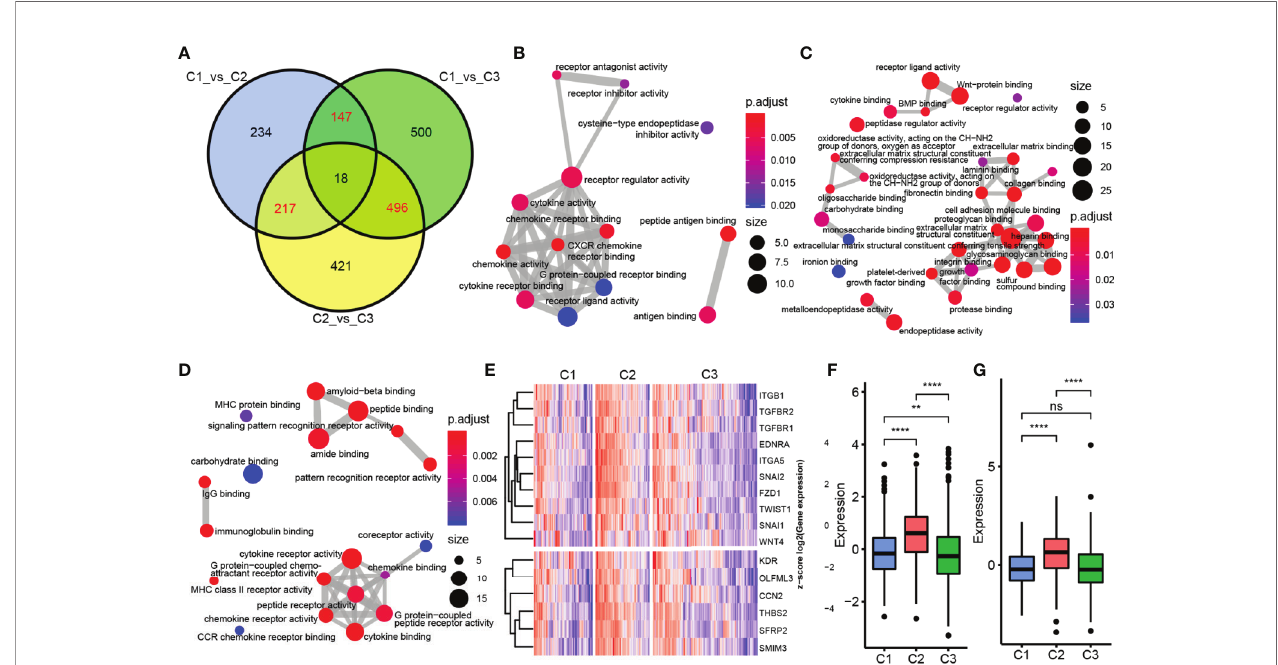
FIGURE 4 | Functional analysis of immune gene module. (A) Wayne map of the difference genes in three subtypes. (B) GO pathway enriched by C1 subtype speci fi c genes. (C) GO pathway enriched by C2 subtype speci fi c genes. (D) GO pathway enriched by C3 subtype speci fi c genes. The thickness of the line indicates the number of shared genes; the color indicates FDR, and the node size indicates the number of enriched genes. (E) The upper panel represents the expression pro fi le clustering heat map of EMT marker genes, and the lower panel represents the expression pro fi le clustering heat map of ESC marker genes. (F) Box plot of expression and distribution of EMT marker gene in three subtypes. (G) The expression distribution of ESC marker gene in three subtypes was different by box line diagram. **P < 0.01, ****P < 0.0001, and ns, ‘ No Signi fi cant ’